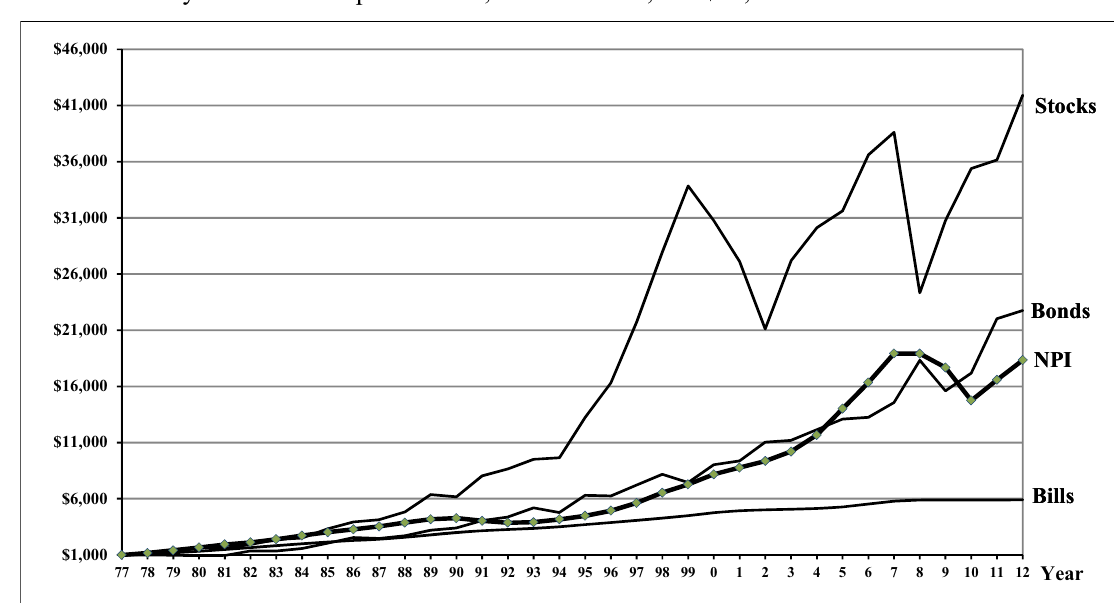
Fig. 1. Cumulative wealth index (compounded value) of asset classes: